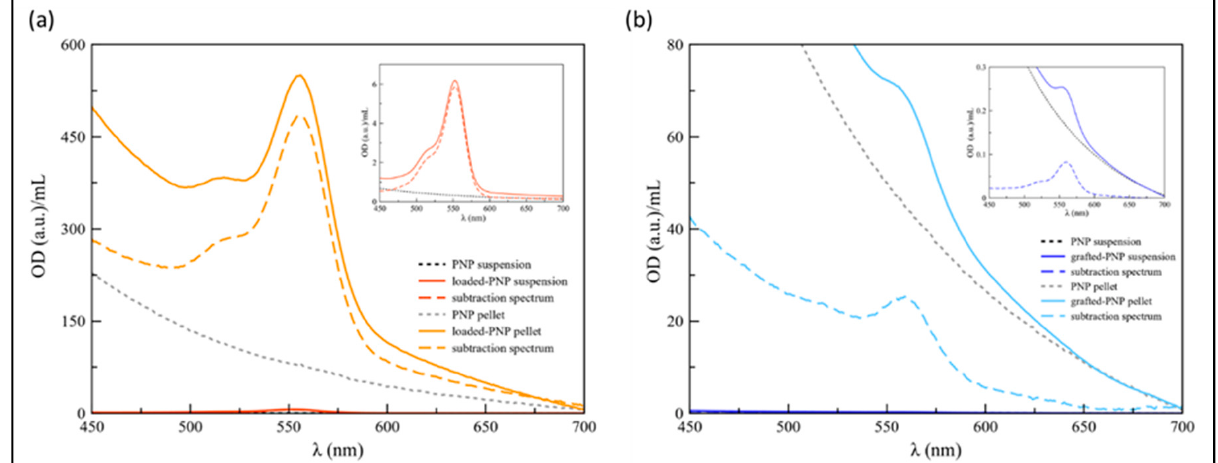
Figure 4. UV-vis optical density (OD) spectra of: ( a ) PNP (dotted black line) and loaded-PNPs (solid red line) suspensions, obtained after the dialysis process, compared with PNP (dotted grey line) and loaded-PNPs pellets obtained after the centrifugation steps; ( b ) PNP (dotted black line) and grafted-PNP (solid light blue line) suspensions, compared to PNP (dotted grey line) and grafted-PNP pellets. In the insets the magnified region for the suspensions. Dashed lines refer to the spectra obtained by the subtraction of the dyelabeled PNP spectra with that of unlabeled PNPs. Spectra were recorded by diluting the suspensions, in MilliQ water, 45 and 3 times, respectively for loaded-PNPs and grafted-PNP. Whereas, the pellets were diluted 100 and 8 times, for the loaded-PNPs and grafted-PNPs, respectively.